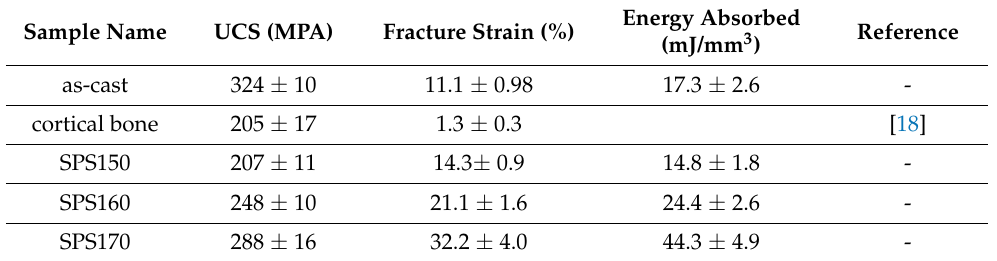
Figure 6. Compressive stress-strain curves of Mg-Zn-Ca BMGs compared to as-cast. Table 3. Results of compressive testing of Mg-Zn-Ca BMGs compared to as-cast and cortical